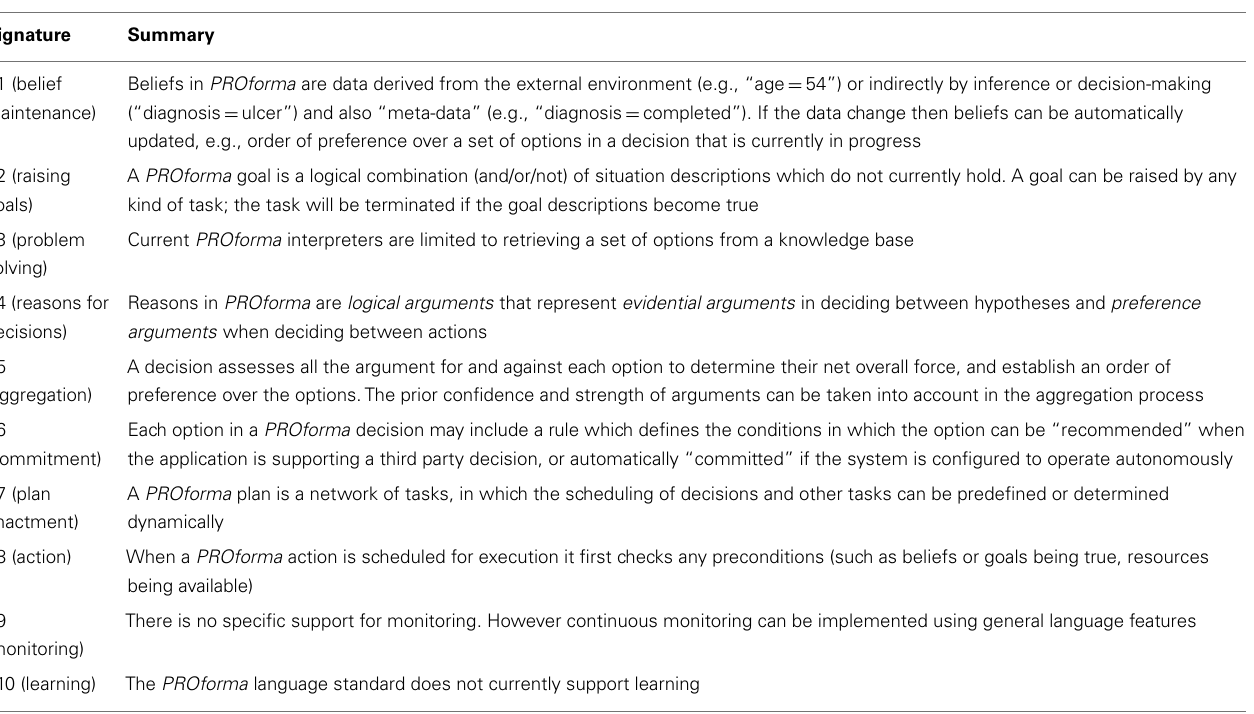
Table 5 |The relation between the canon signatures and task representations in the PROforma modeling